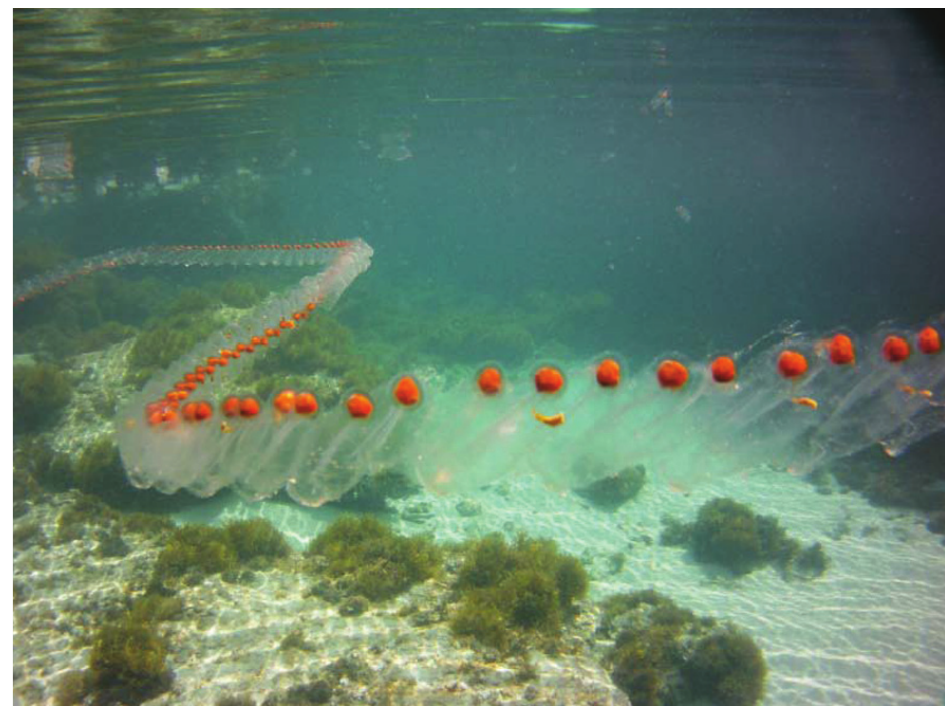
Figure 2. A chain of Salpa maxima in the waters of Salento. Picture by R. Bracale.